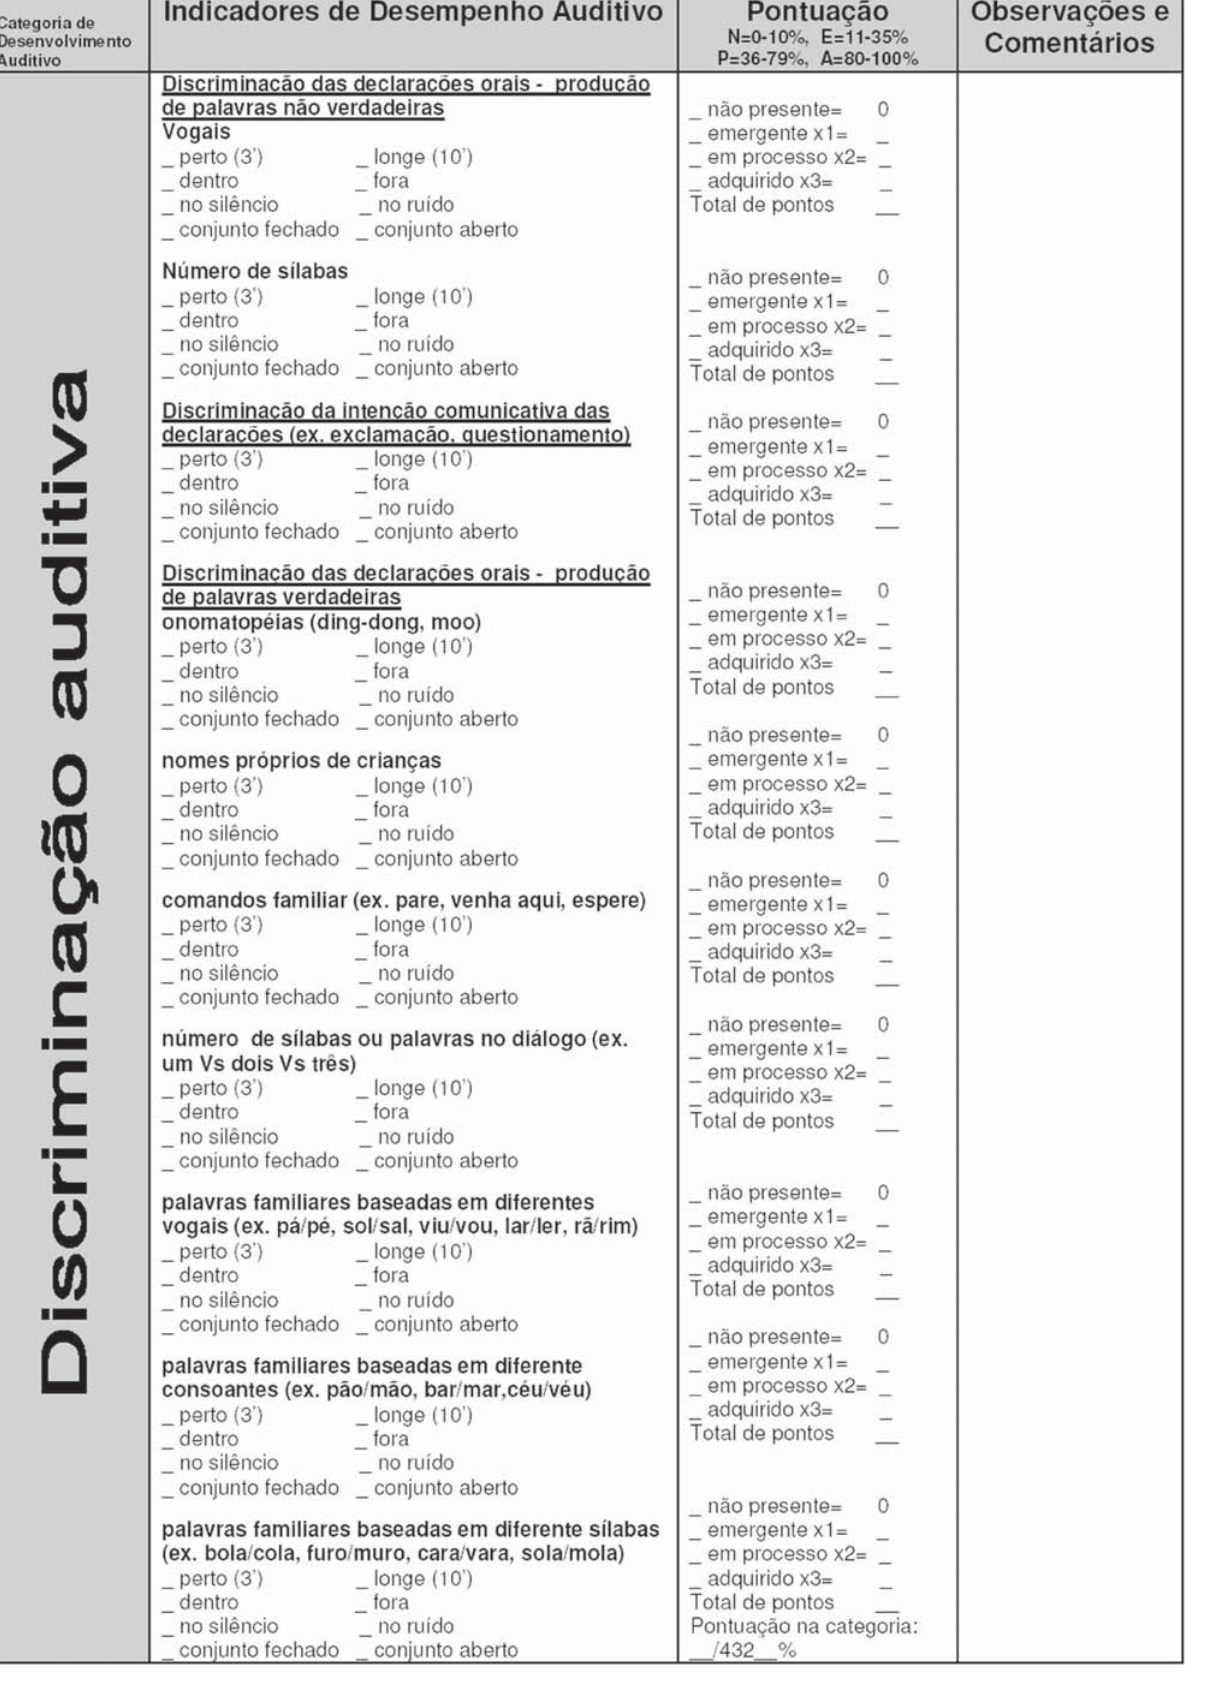
Figures 1D- Final FAPI translation into Portuguese (original in English: Stredler-Brown & Johnson 25